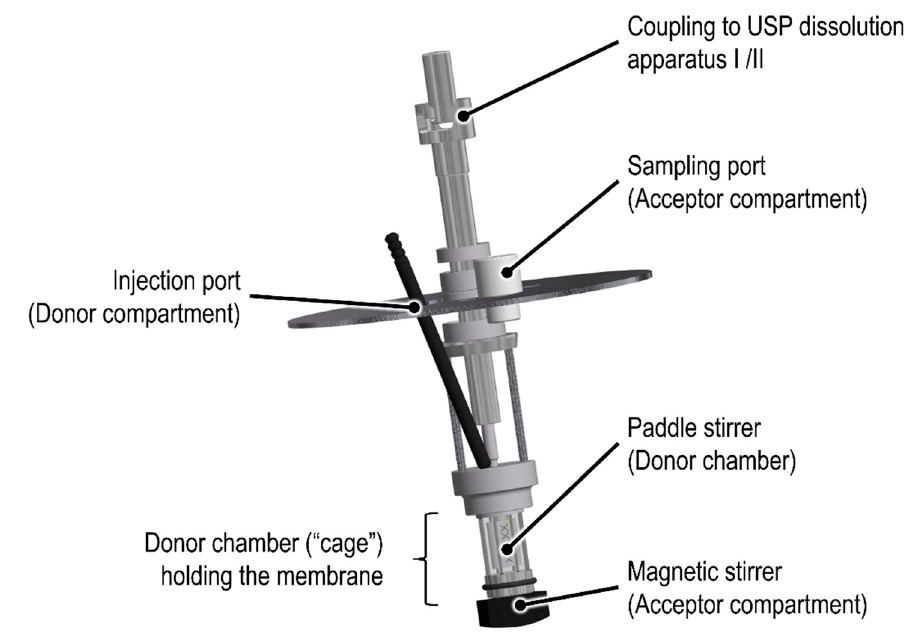
Figure 1. Schematic of the commercial Pharma Test Dispersion Releaser (PTDR).